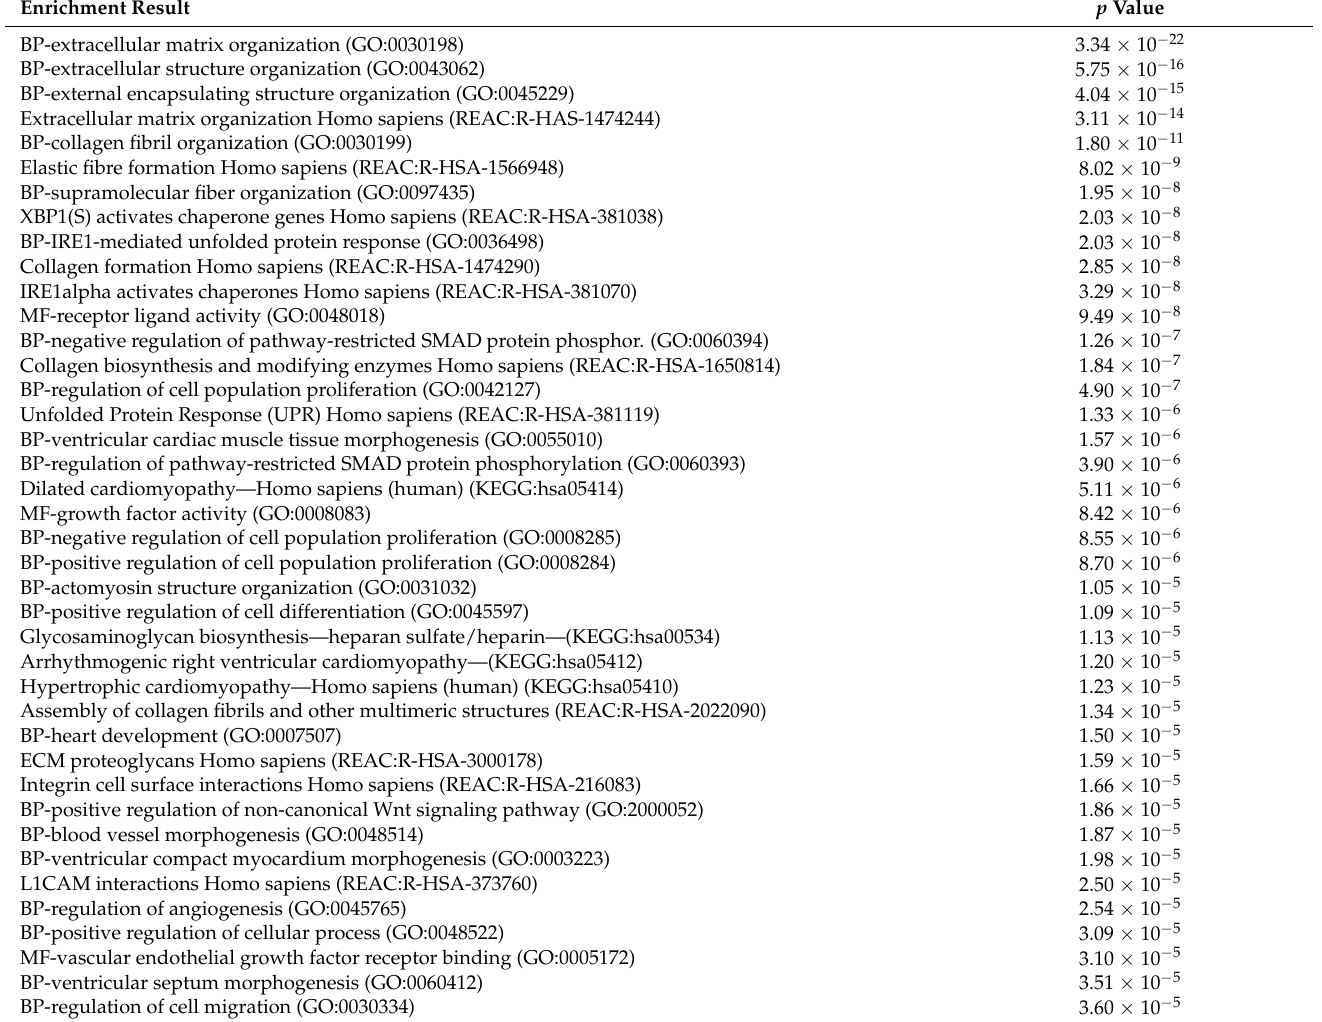
Table 2. Top 40 enrichment results from KEGG, reactome and GO biological processes and molecular functions ranked by false discovery rate (FDR). BP = Biological Processes and MF = Molecular Function where pval indicates the nominal p -value for each enrichment